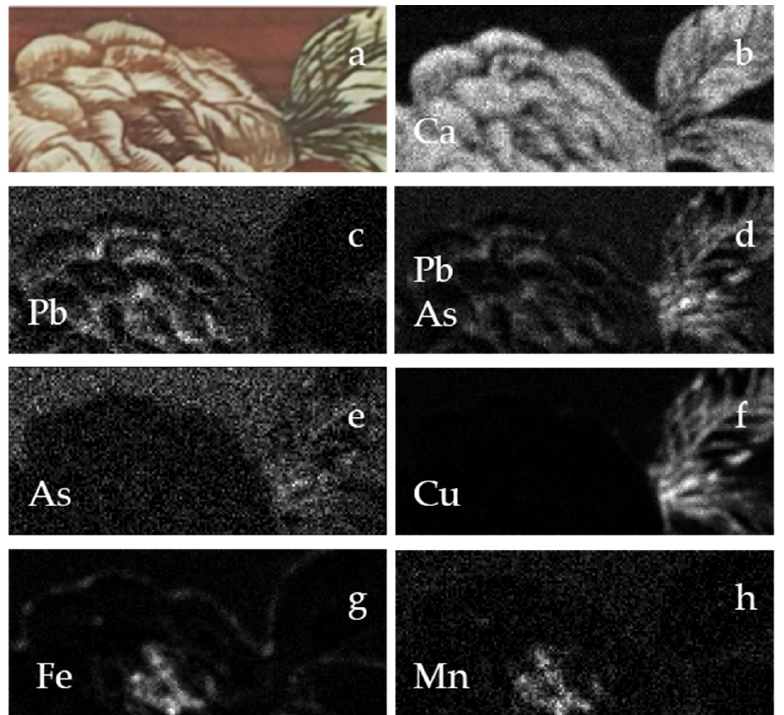
Figure 5. Elemental maps of the first area of the drawer obtained by the INFN-CHNet MA-XRF scanner. ( a ) Visible. The maps presented are: ( b ) Ca K α transition; ( c ) Pb L β transition; ( d ) Pb L α /As K α transitions; ( e ) As K β transition; ( f ) Cu K α transition; ( g ) Fe K α transition; ( h ) Mn K α transition.